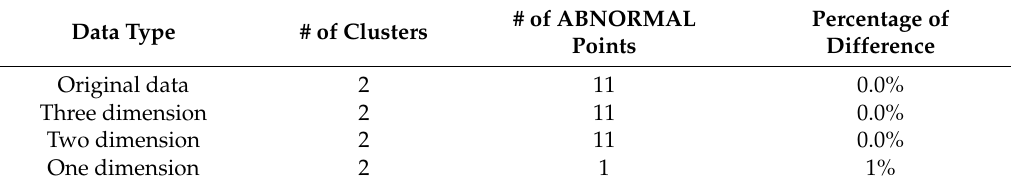
Table 3. The efficiency of Principal Components Analysis (PCA)